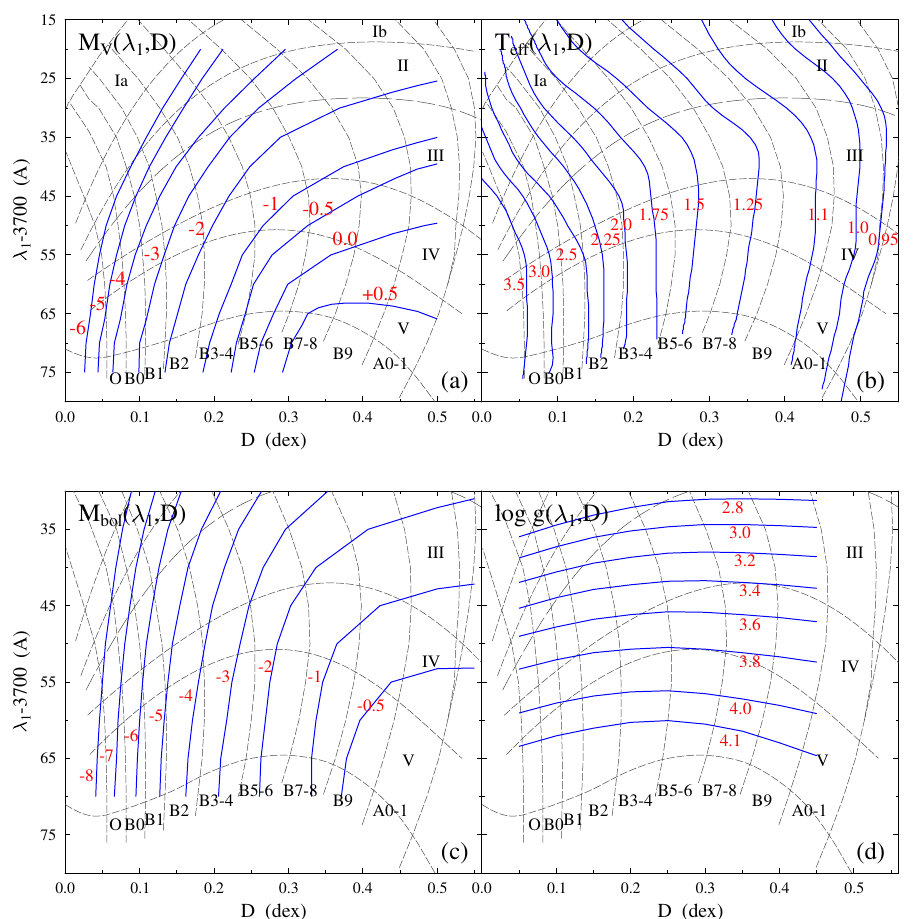
Figure 3. Empirical calibrations of absolute magnitudes M V and M bol and parameters T eff and log g as a function of the BCD parameters ( λ 1 , D ) . The horizontal black dashed lines separate the MK luminosity classes indicated on the left side of each panel. The vertical black dashed lines separate the groups of the MK spectral types specified at the bottom of each panel. The blue lines represent the calibrations of the indicated astrophysical parameters, respectively, labeled in red (in units of magnitude for M V and M bol ), T eff ( K ) /10 4 for effective temperatures and dex for log g . Figures adapted: ( a ) from Zorec and Briot [18], ( b ) from Zorec et al. [19], ( c , d ) from Zorec